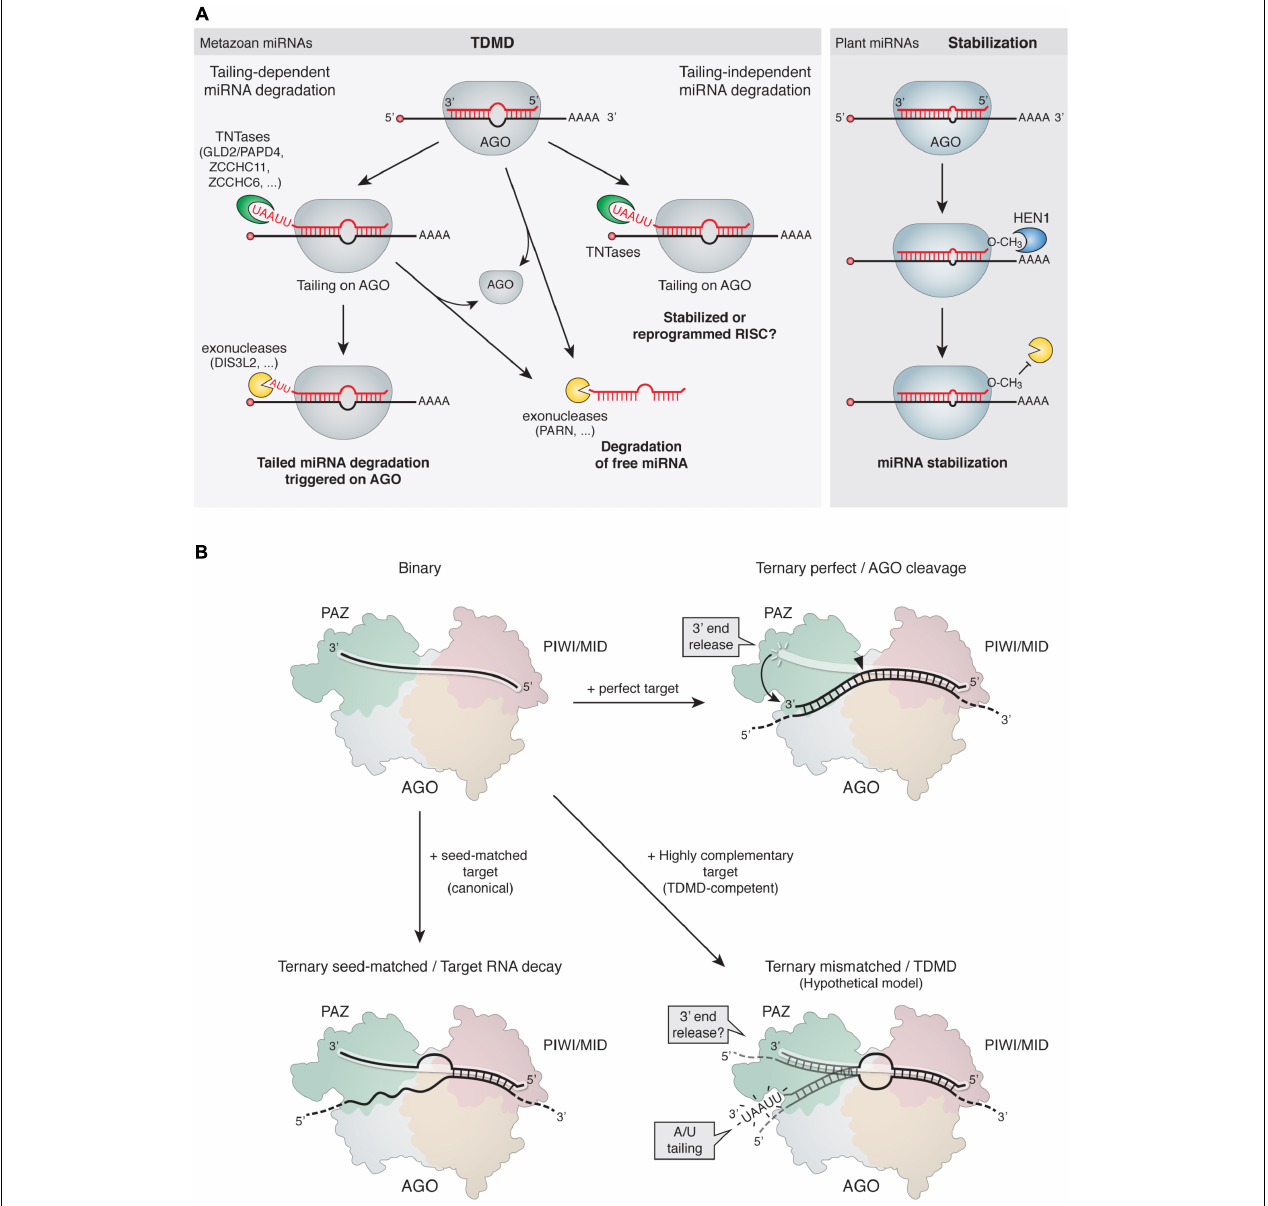
FIGURE 3 | Mechanism of TDMD. (A, Left) Proposed models for TDMD. In tailing-dependent miRNA degradation, highly complementary target RNAs would either expose the miRNA 3 (cid:48) ends to TNTases by detaching them from AGO’s 3 (cid:48) -end binding pocket in the PAZ domain (see panel B ), favor the kinetics of TNTases on the 3 (cid:48) ends of the bound miRNAs, or both. The tailed species would subsequently serve as preferred substrates for 3 (cid:48) -to-5 (cid:48) exoribonucleases. Alternatively, tailing might promote miRNA unloading from AGO for subsequent degradation of free miRNAs in the cytoplasm. In tailing-independent miRNA degradation, highly complementary target RNA would promote unloading of miRNAs from AGO, leading to subsequent degradation of free miRNAs in the cytoplasm. Increased tailing could be a parallel process, rather than a cause of degradation, induced by highly complementary target RNAs binding to miRNAs. Tailing could in turn have either stabilizing effects or an influence on the activity of miRNAs. (Right) In plants, 2 (cid:48) - O -methylation at the 3 (cid:48) end of miRNAs prevents 3 (cid:48) tailing and stabilizes the modified miRNAs (see main text). (B) Structural rearrangements induced on AGO by binding of target RNAs with different architectures. (Top left) Binary complex of a miRNA loaded on AGO; the miRNA 5 (cid:48) end is bound to the MID domain while the 3 (cid:48) end is bound to the PAZ domain and therefore protected from terminal modifications. (Top right) Ternary complex comprising an AGO-loaded siRNA (or miRNA) bound to a perfectly complementary target RNA; the extensive 3 (cid:48) pairing releases the 3 (cid:48) end of the siRNA and induces a conformational change that switches the complex from an inactive to an active slicing conformation, cleaving the target at the catalytic site (solid arrowhead). The rapid release of the cleaved target would preclude tailing of the AGO-bound miRNA, which would return to its protected conformation. (Bottom left) Ternary complex comprising an AGO-loaded miRNA bound to a canonical seed-matched target RNA. Due to lack of pairing to the 3 (cid:48) end of the miRNA, the 3 (cid:48) end would remain bound and protected within the AGO PAZ domain. (Bottom right) Hypothetical structure of a ternary complex comprising an AGO-loaded miRNA bound to a TDMD-competent target RNA; the extensive 3 (cid:48) pairing might expose the 3 (cid:48) end in a conformation that would render it susceptible to attack by modifying enzymes (e.g., TNTases).